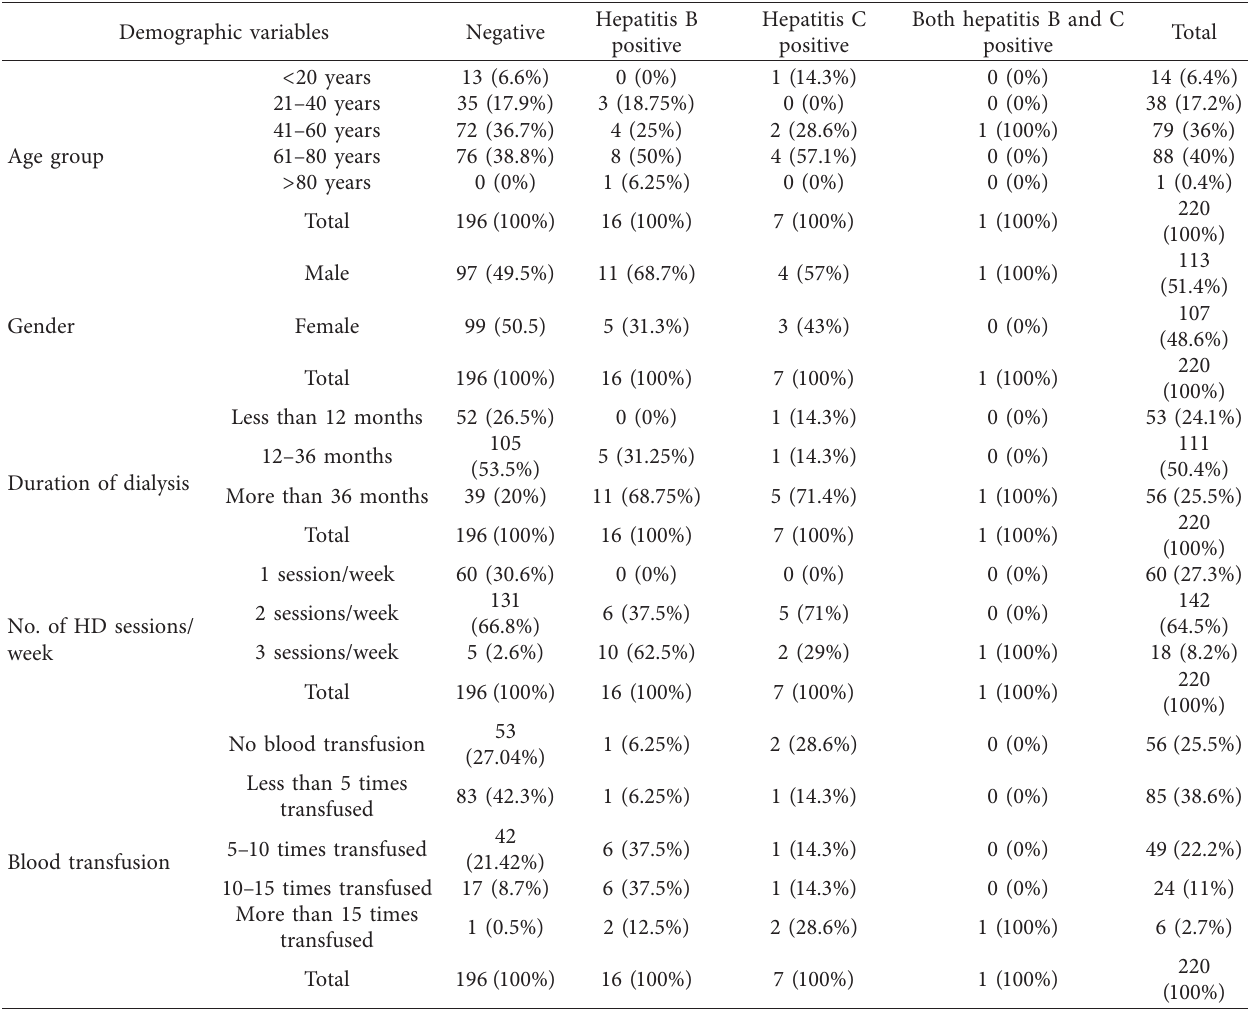
Table 2: The prevalence of HBV and HCV in relation to demographic variables of the respondents.